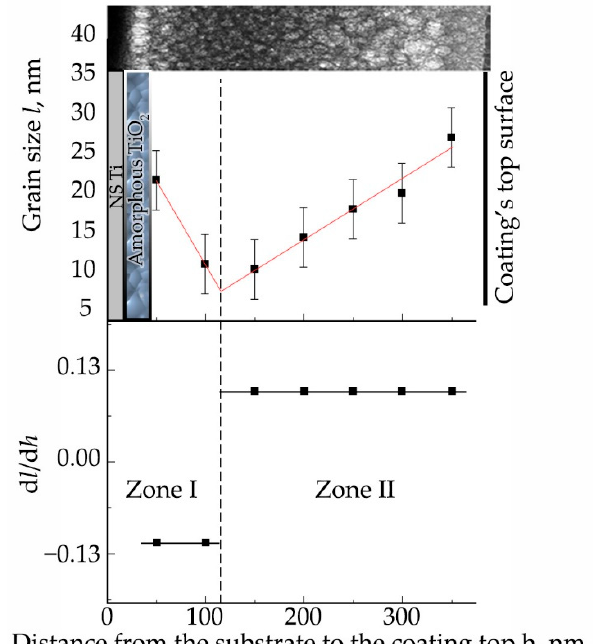
Figure 13. Grain size distribution in the coating ( l ) as a function of the distance ( h ) from the interface to the free surface of the coating in nm. The graph also shows the derivatives of the grain size distribution function d l /d h ( h ).